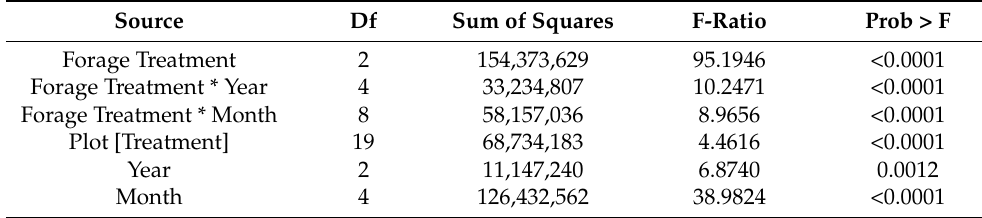
Table 2. ANOVA results from analysis of herbage mass data. * Refers to treatment interaction. Source Df Sum of Squares F-Ratio Prob > F Forage Treatment 2 Forage Treatment *